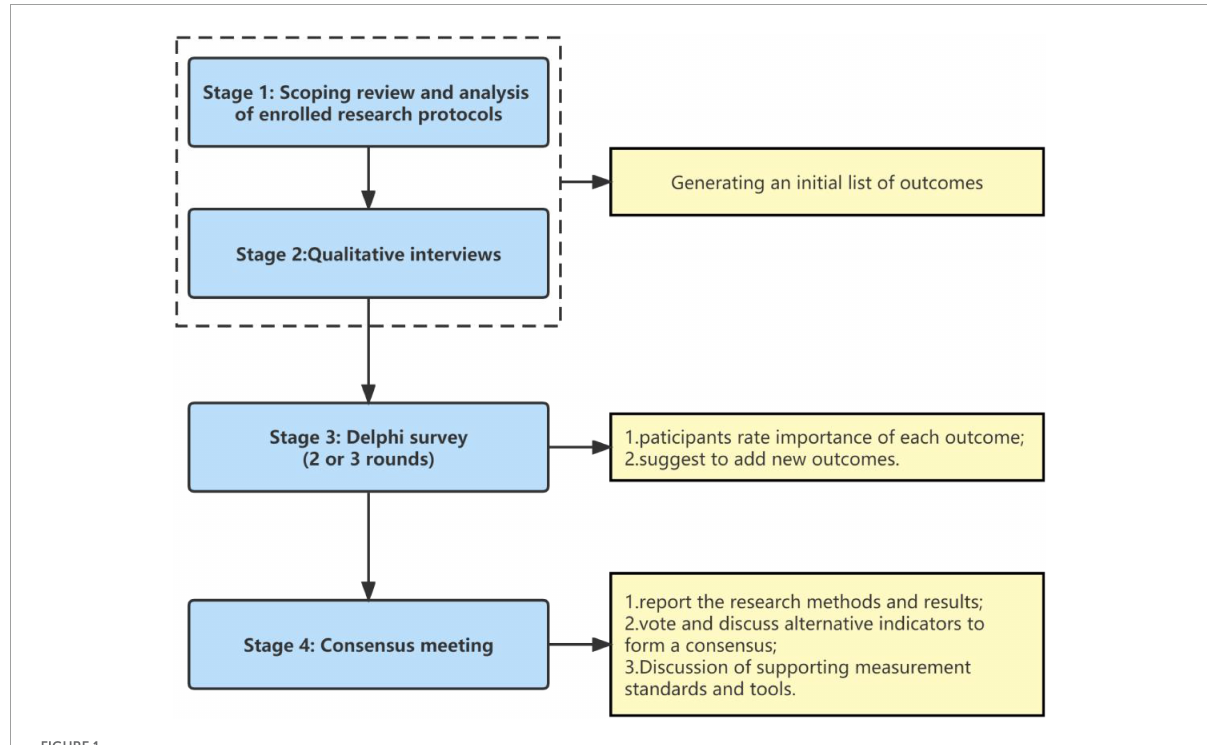
FIGURE1 Key phases in